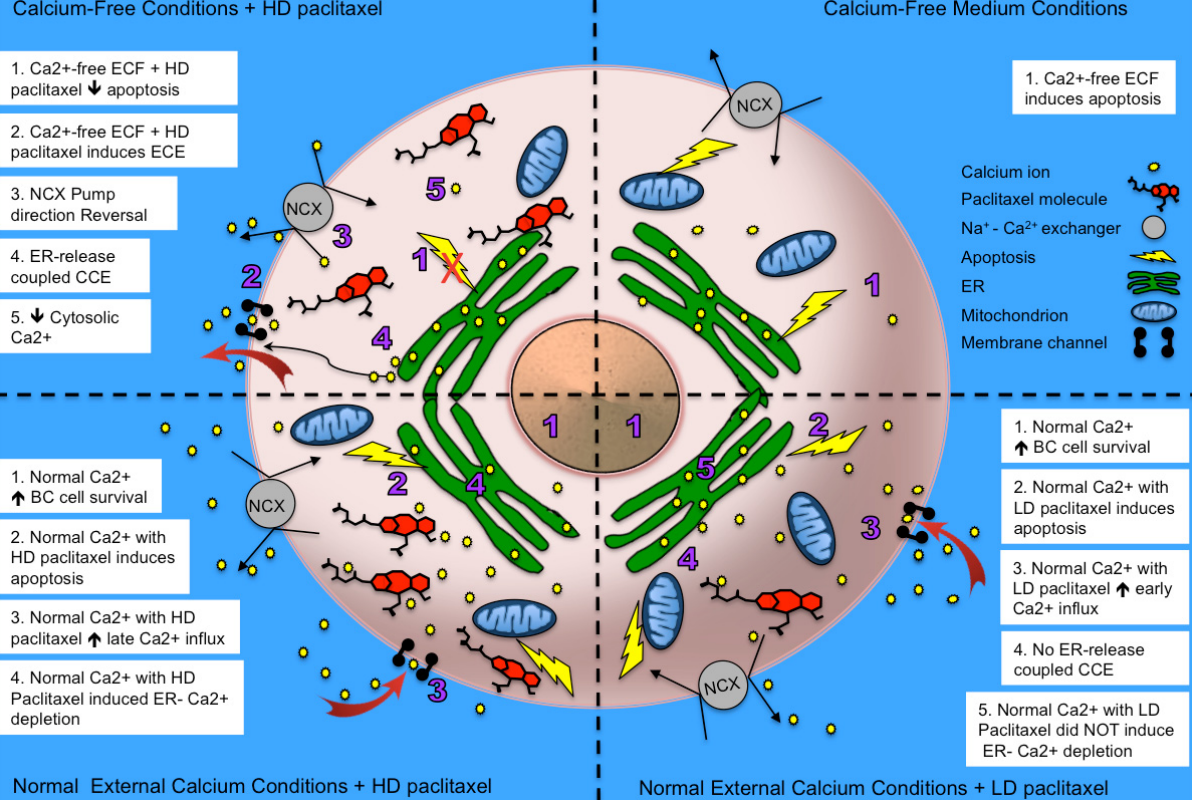
Figure 7. Graphical summary of key results. A schematic of a breast cancer cell from